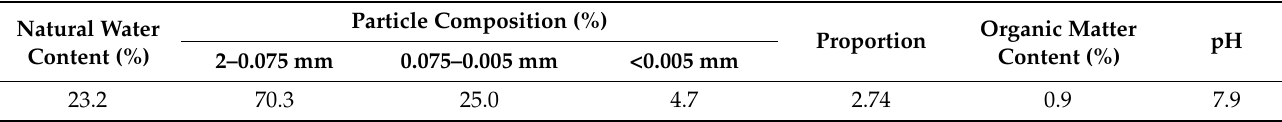
Table 1. Basic physicochemical properties of cover soil.